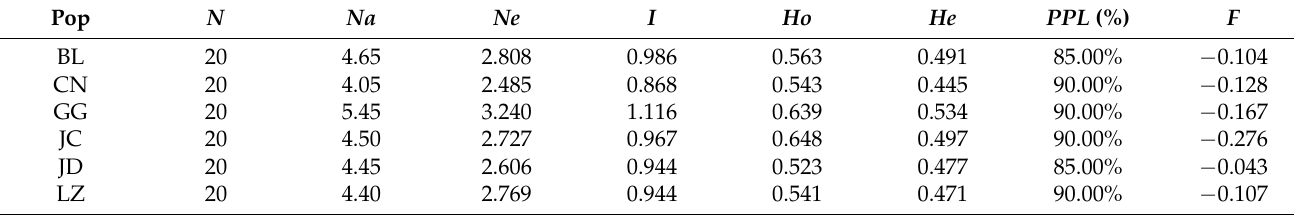
Table 2. Genetic diversity statistics in 15 populations of S. moorcroftiana